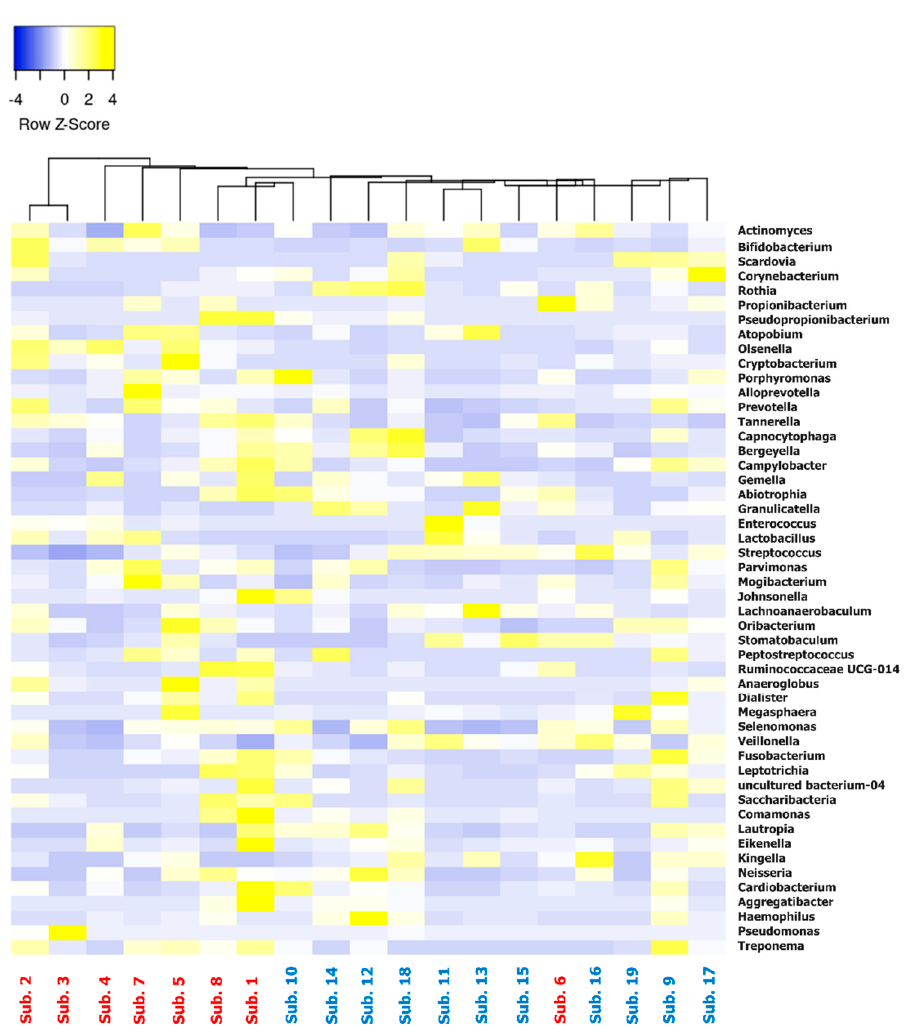
Figure 5. Heat map clustered according to genera found within the samples and ordered according to their relative abundance. Subjects (malodor—red; non-malodor—blue) are clustered according to genera found in each sample.